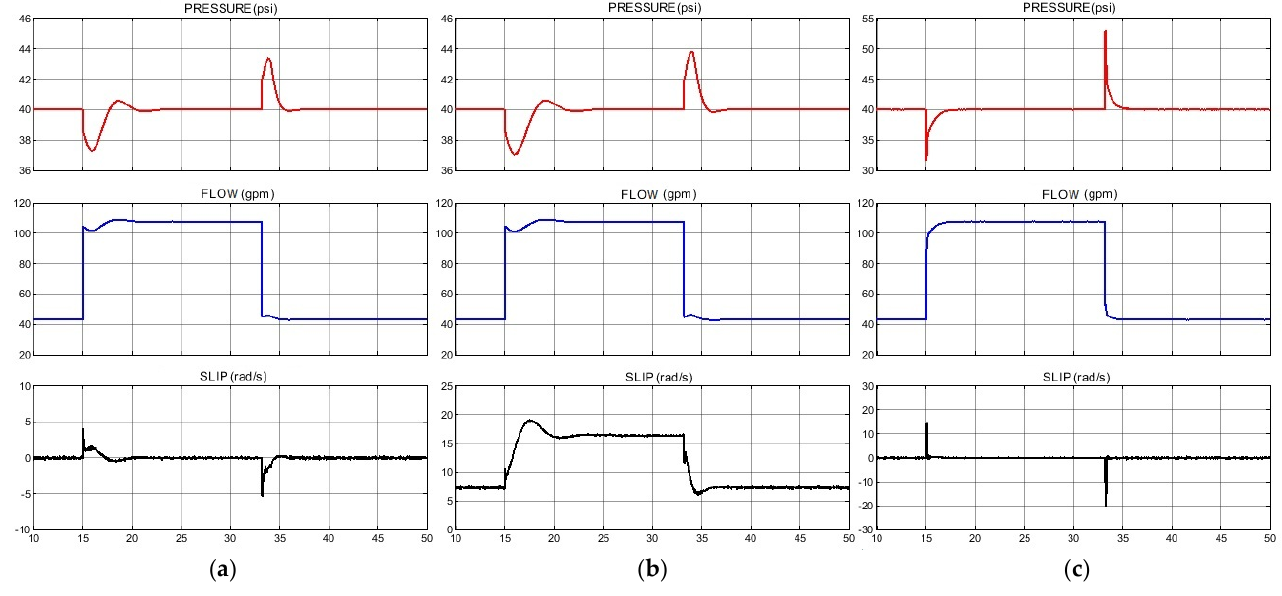
Figure 12. Comparison of the dynamic response under three different conditions: ( a ) with slip compensation and hydropneumatic tank; ( b ) without slip compensation; ( c ) without hydropneumatic tank.